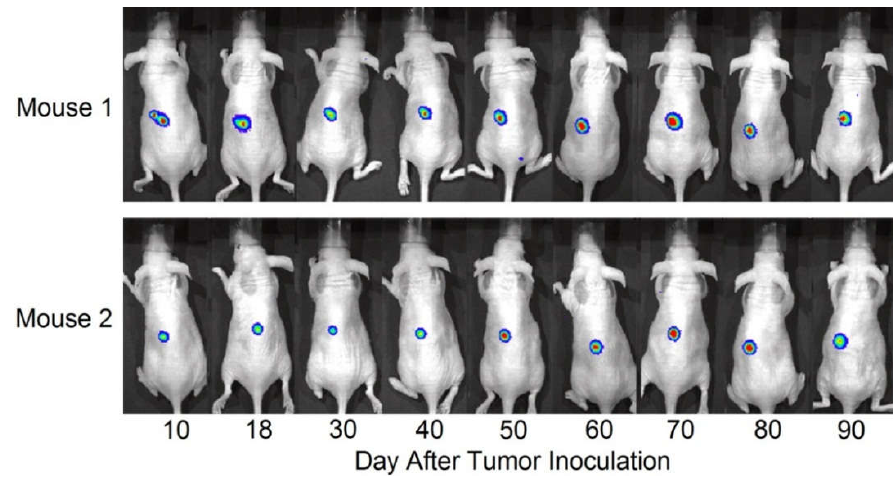
Figure 6. Visualization of α -Lactalbumin Gene Expression during in vivo Growth of Human TNBC. Human HCC1937-hlac-Luc cells express firefly luciferase under regulation of the human α -lactalbumin promoter. These stably transfected human TNBC cells were inoculated subcutaneously in the abdominal flanks of 6–8 week old immunodeficient, athymic, female NU/J mice and imaged regularly over a 90 day period for whole body full spectrum wavelength emission induced by injection with luciferin substrate. The stable bioluminescent signals obtained over 90 days in two tumor inoculated mice indicate that human TNBC tumors growing in vivo show stable constitutive α -lactalbumin gene expression over an extended period of time.